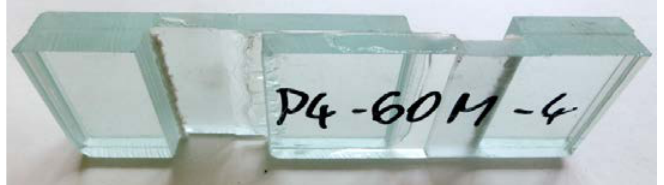
Fig. 13 Trosifol delamination, sample statically loaded at 60 °C.